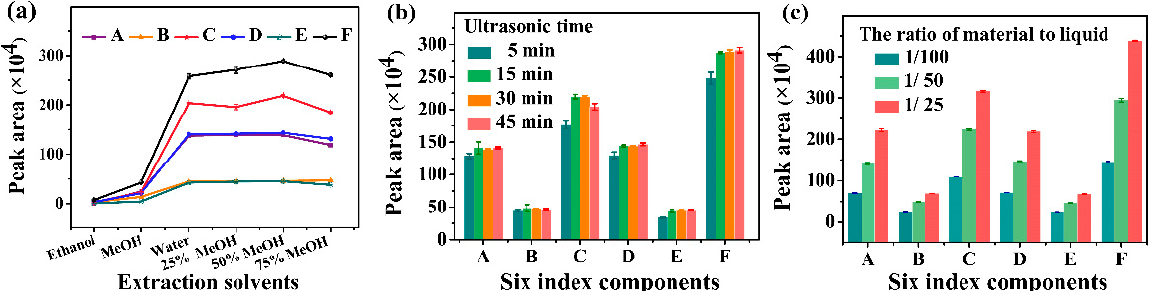
Figure 2. Optimization of sample preparation conditions of GR formula granules. ( a ) the effect of extraction solvents including ethanol, MeOH, water, 25% MeOH, 50% MeOH, and 75% MeOH, on the extraction efficiency of six index components; ( b ) the effect of ultrasonic time (5, 15, 30, and 45 min) on the extraction efficiency of six index components; and ( c ) the effect of the ratio of material to liquid (1/100, 1/50, and 1/25) on the extraction efficiency of six index components.